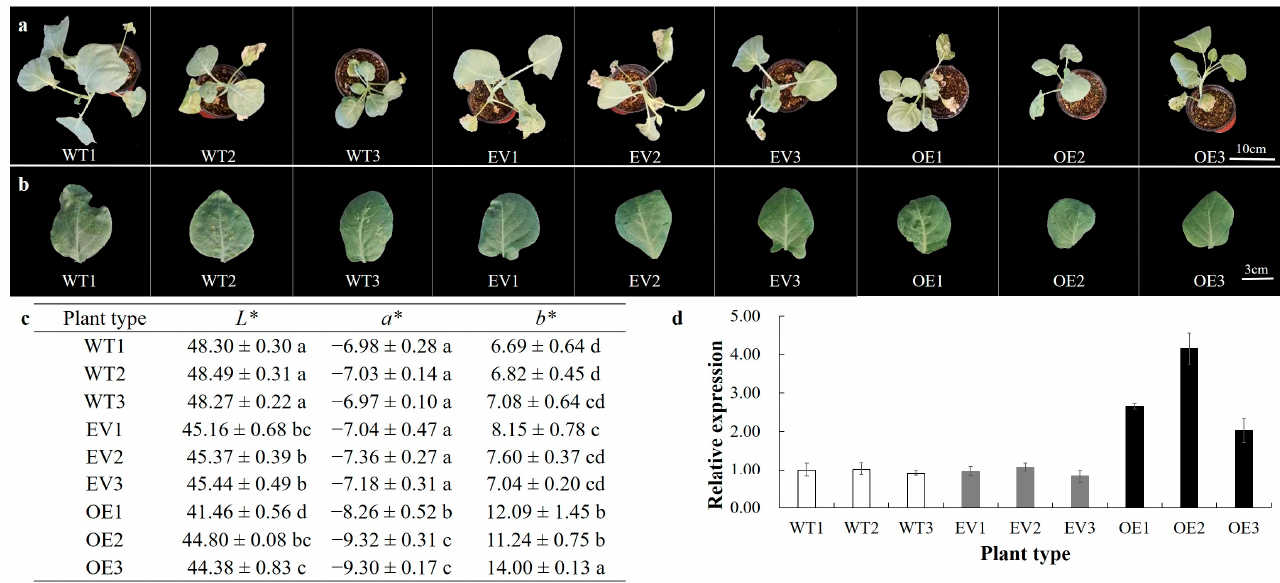
(green) and chloroplast autofluorescence (red). Bars = 30 µ m.